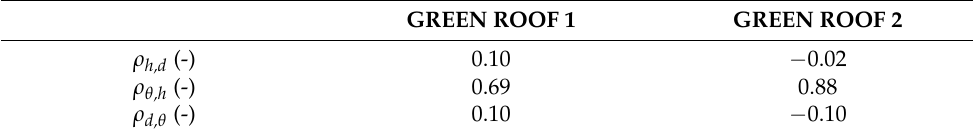
Table 3. Correlation indexes among rainfall